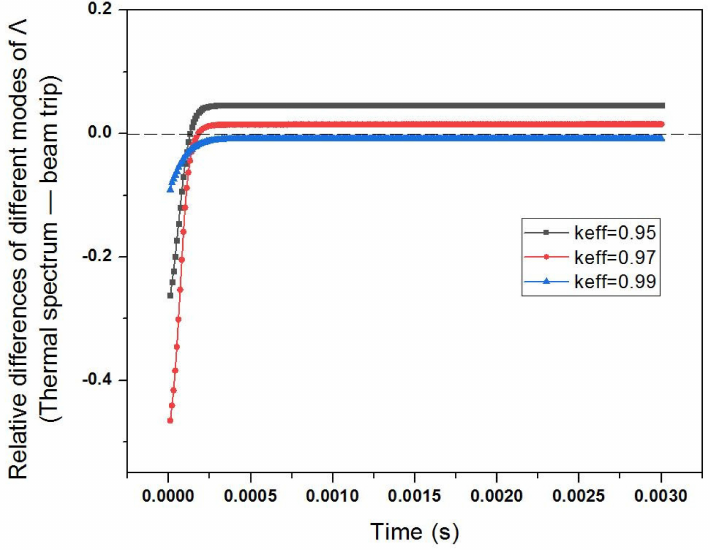
Figure 9. Relative differences in Λ with time for different modes of the thermal spectrum, under different subcriticalities and beam trips.